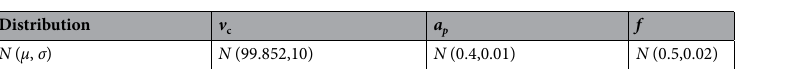
Table 5. The distribution parameters of machining